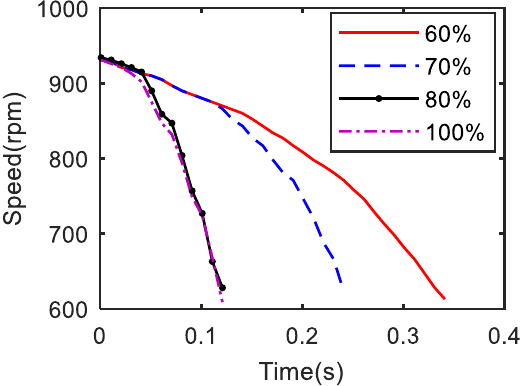
Figure 13. AMT input shaft’s speed curves under different duty cycles of TB solenoid valve.